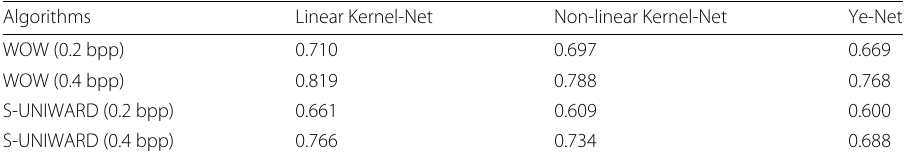
Table 2 The performance of Linear Kernel-Net, Non-linear Kernel-Net, and Ye-Net on resampled